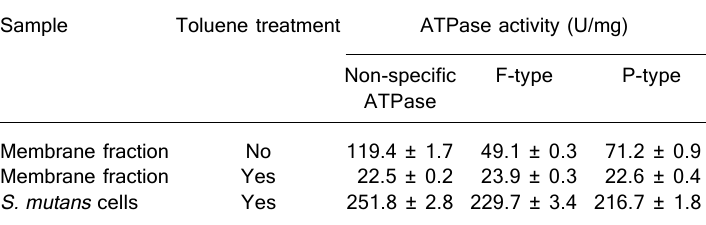
Table 1. Specific activity of P- and F-ATPase present in toluene-permeabilized Streptococcus mutans cells and membrane fractions.